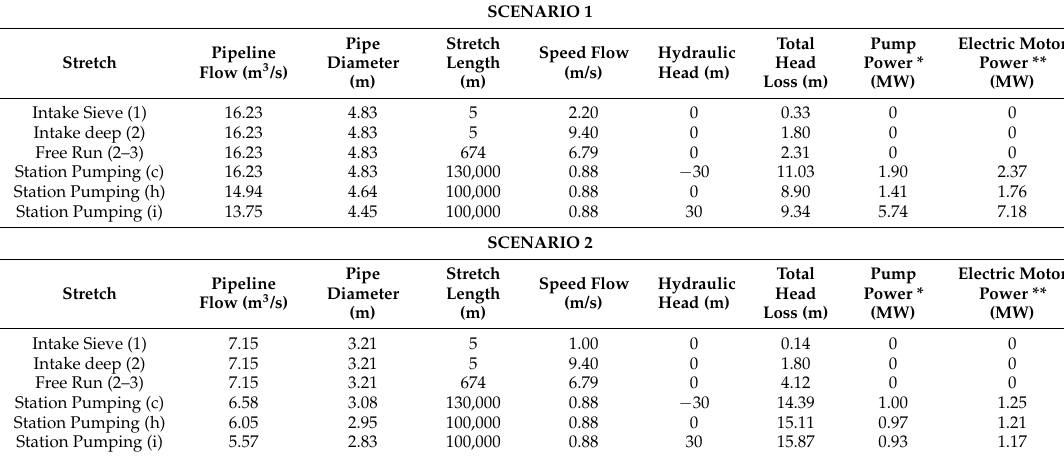
Figure 13. Stretches of the route of the underwater pipeline River Huanghe/Dalian-China. Table 6. Characterization of Pipeline of River Huanghe/Dalian-China. Scenario 1 (200 L/capita/day), Scenario 2 (81 L/capita/day).